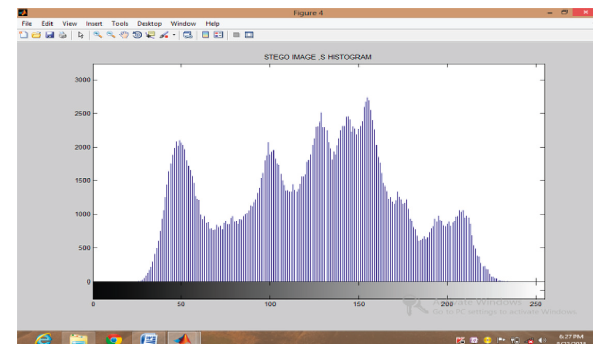
Figure 18: Histogram of stego image of house.